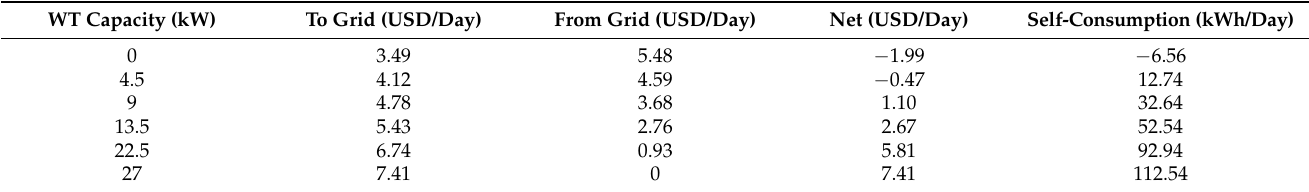
Table 5. Daily energy cost and self-consumption for different WT capacities (PV = 15 kWp).